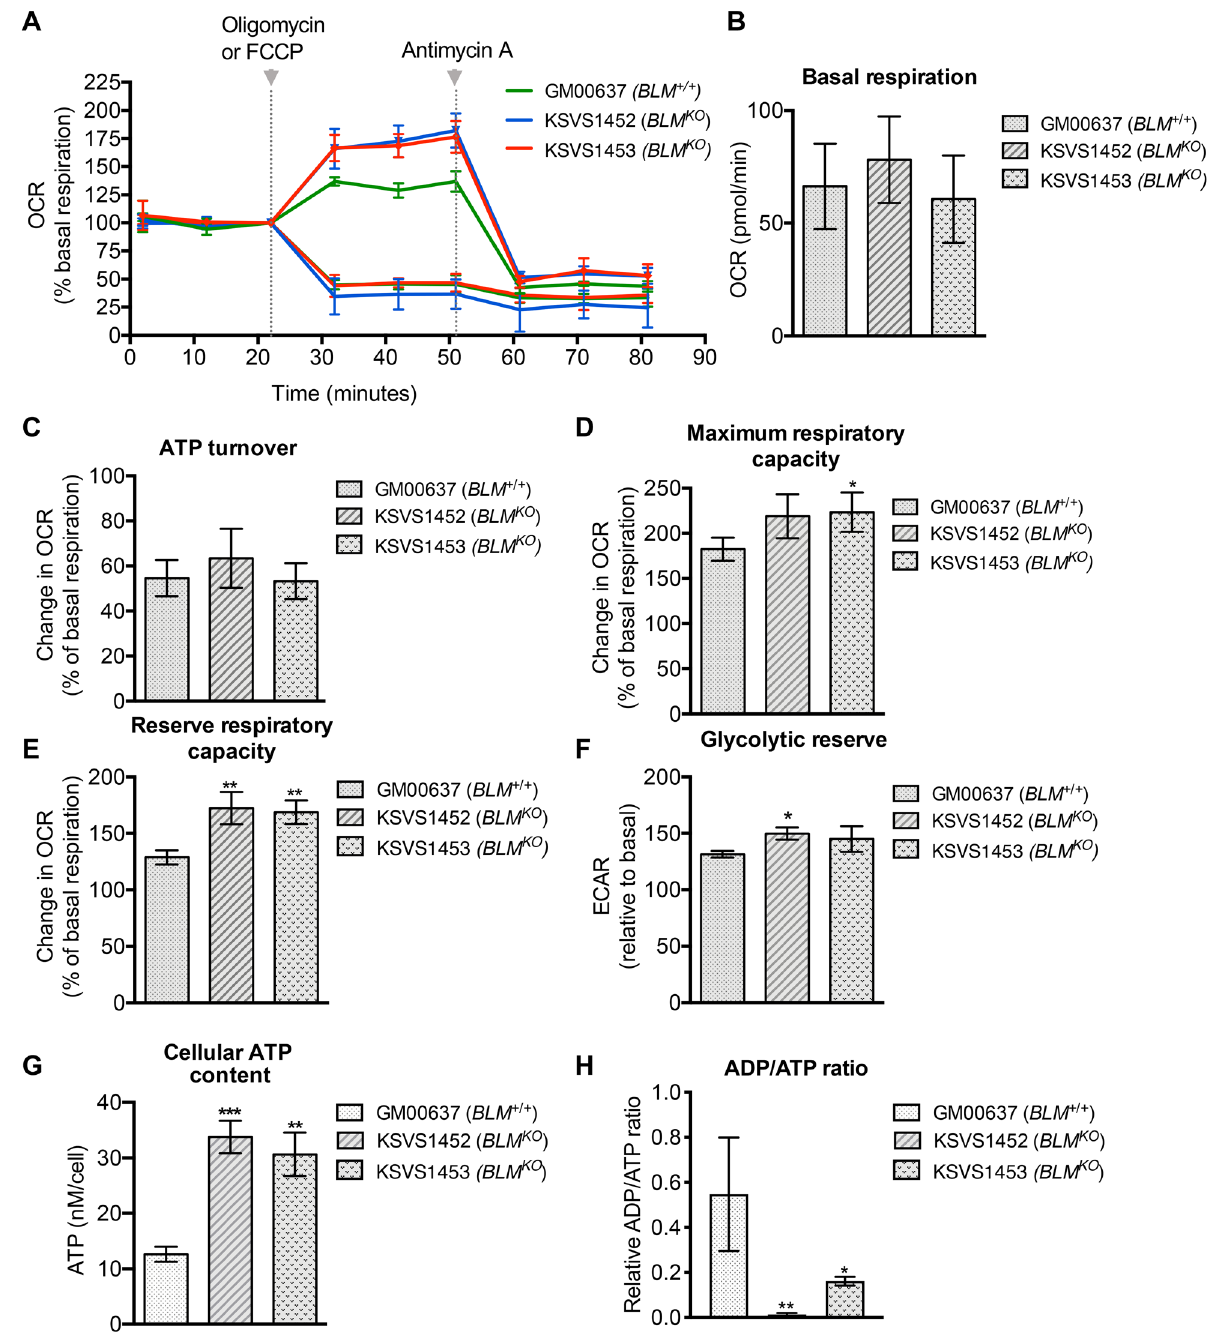
Figure 6. Bioenergetic profile of BLM-deficient cells. (A ) Oxygen consumption rates (OCR) of BLM- proficient cell line GM00637 and BLM-deficient cell lines KSVS1452 and KSVS1453 were measured on a XF-96 Extracellular Flux Analyzer (Seahorse Bioscience) after addition of oligomycin or FCCP at 22 min and after addition of antimycin A after 51 min. From measurements in ( A ) basal respiration, ( B ), ATP turnover rate ( C ), maximum respiratory rate ( D ) reserve respiratory capacity ( E ) and glycolytic reserve ( F ) were calculated. All measurements were normalized to basal rate (data point at 22 min). ( G ) Total cellular ATP content was measured in whole cell extracts of BLM-proficient cell (GM00637) and BLM-deficient cells (KSVS1452, KSVS1543) using a luciferase-based assay. ( H ) ADP/ATP ratio was measured in whole cell extracts of BLM- proficient cells (GM00637) and BLM-deficient cells (KSVS1452, KSVS1453) using a bioluminescent method based on the conversion of ATP by